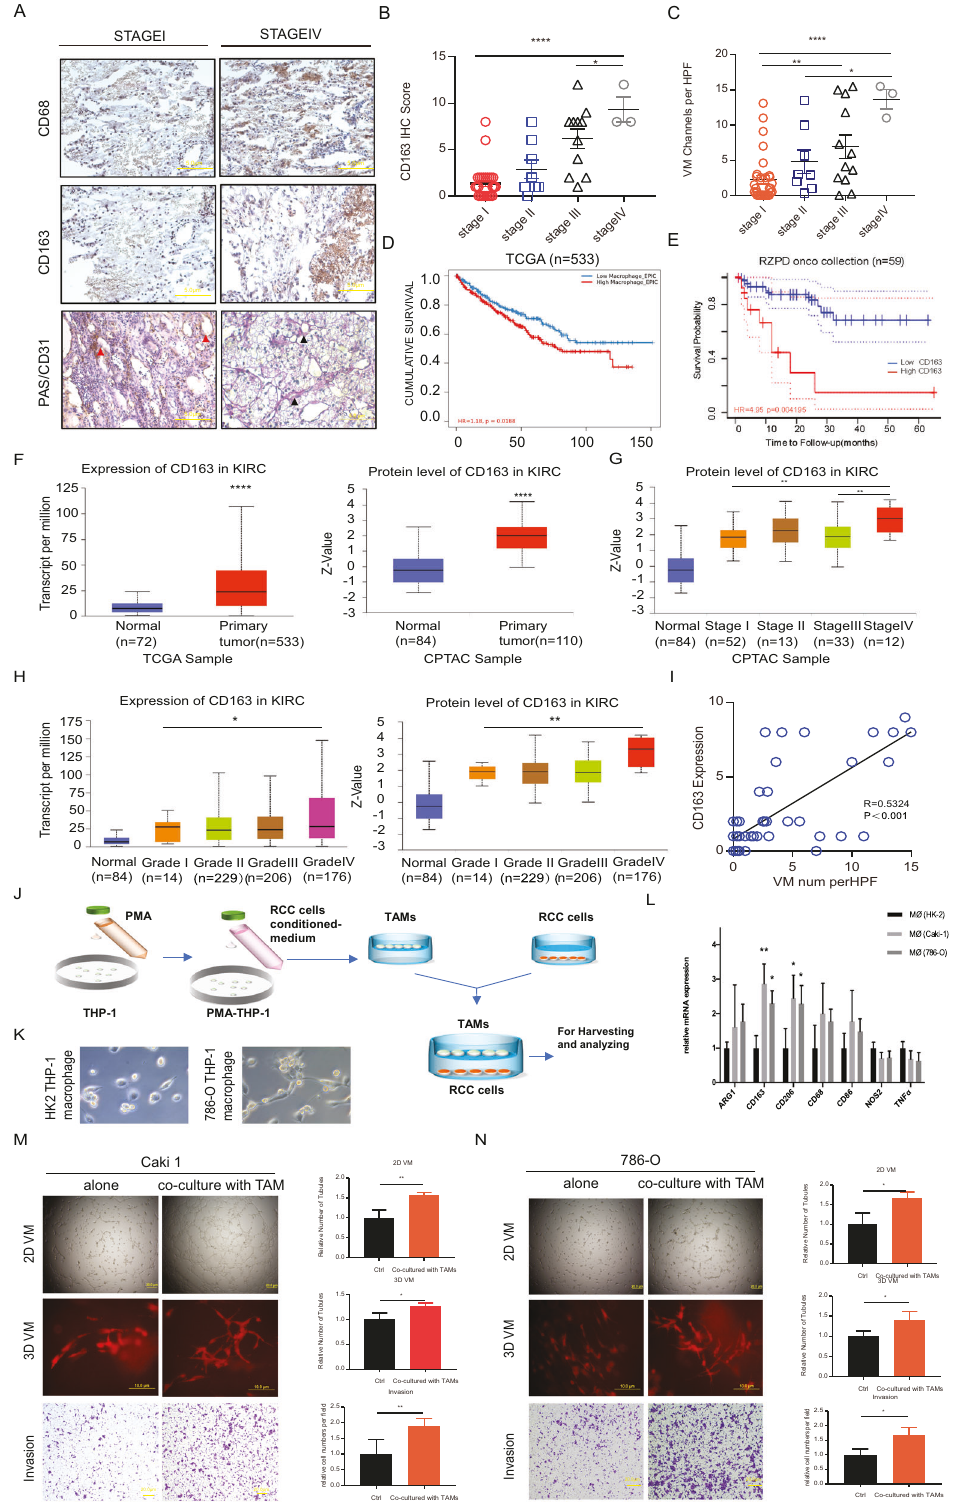
data. To detect TAMs and VM, we performed immunostaining of the M2 macrophage biomarkers CD68/CD163 and implemented PAS/CD31 double staining. The results (Fig. 1A) indicated that both TAM (CD68/CD163 positive) recruitment and VM (PAS positive/CD31 negative) were signi fi cantly enhanced in